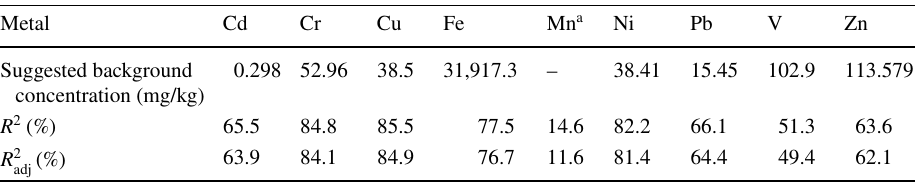
Table 2 Suggested background concentrations of explored metals